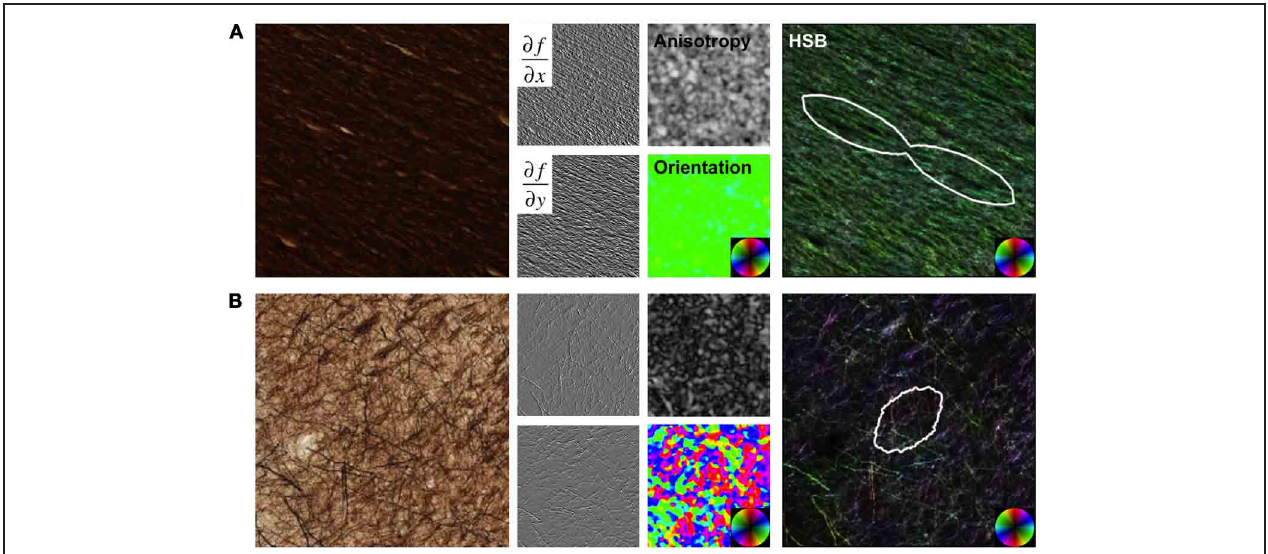
FIGURE 1 | Structure Tensor Analysis. Images from a region of high anisotropy in the corpus callosum (A) and a region with low anisotropy from the cortical gray matter (B) are shown as examples. Original images were convolved with Gaussian derivative filters, and maps of anisotropy and orientation were derived from the structure tensor matrix at each